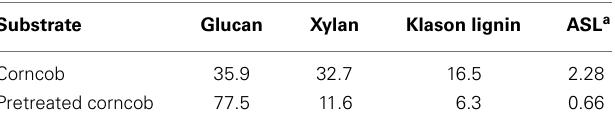
Table 2 | Chemical compositions of corncob before and after combined pretreatment .